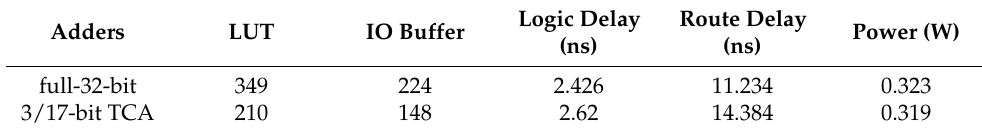
Table 2. Comparison results in the FPGA